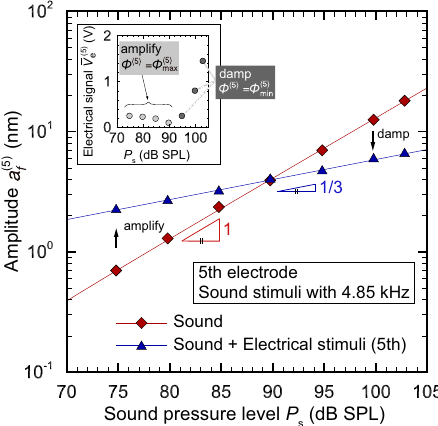
Figure 7. Relationship between amplitude a f at x ( 5 ) and sound pressure level P s for f s = 4.85 kHz. The case with sound stimuli showed a linear response, while the case with both sound and electrical stimuli showed a nonlinear response with a power 1/3. The electrical signal ¯ V is plotted in the